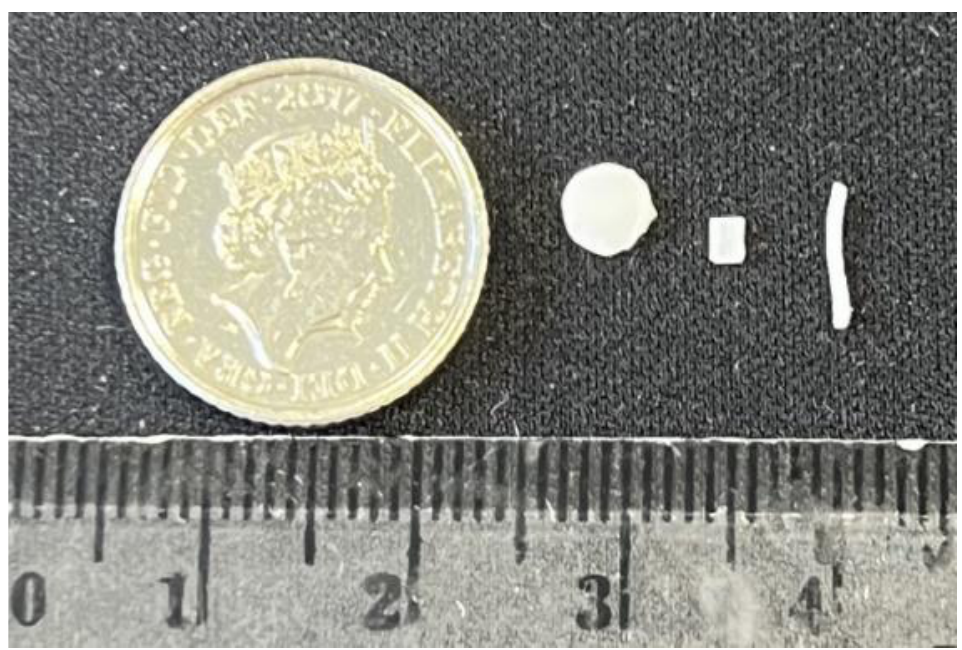
Figure 2. Different shapes of TA-loaded PCL implants printed using GeSiM 2.1 Bioscaffolder 3D bioprinter.